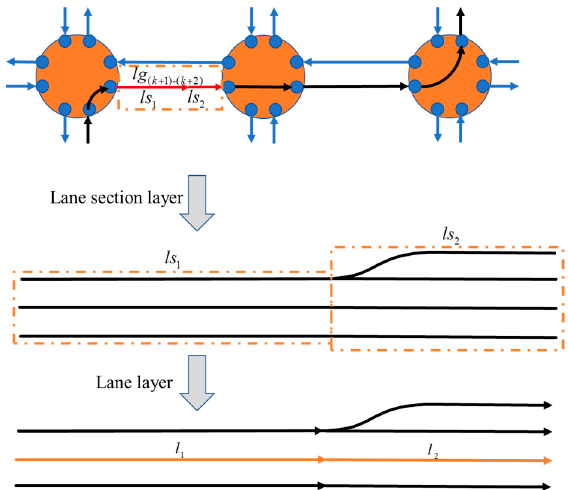
Figure 5. The route planning from the lane group level to the lane section level, and then to the lane level.